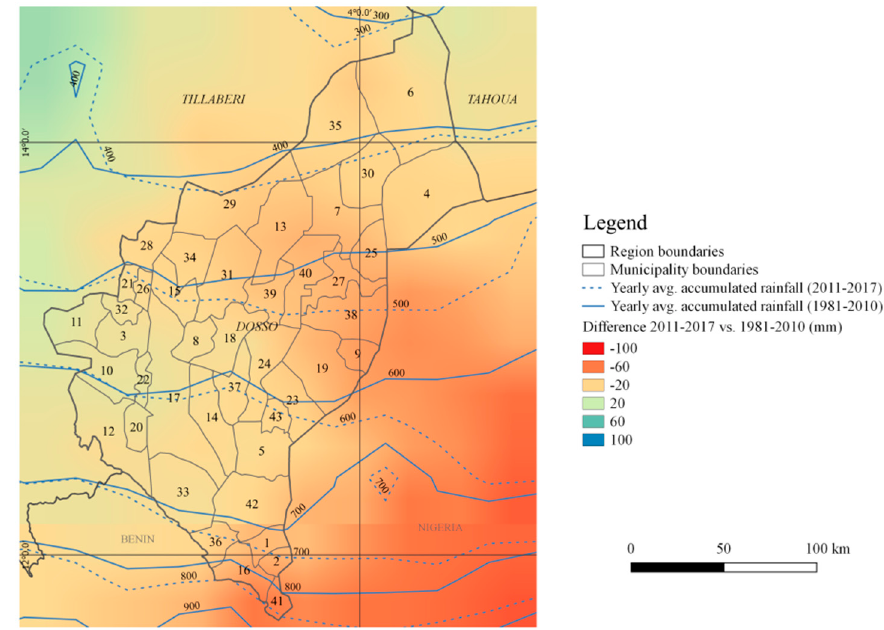
Figure 4. The difference in average accumulated rainfall during 2011–2017 and 1981–2010 (rainfall data from the Climate Hazards group InfraRed Precipitation with Stations (CHIRPS) dataset).